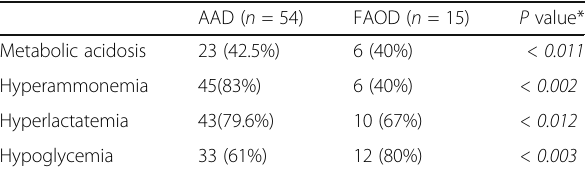
Table 6 The difference between the commonly diagnosed cases in our study in relation to metabolic acidosis, hyperammonemia, hyperlactatemia, and hypoglycemia